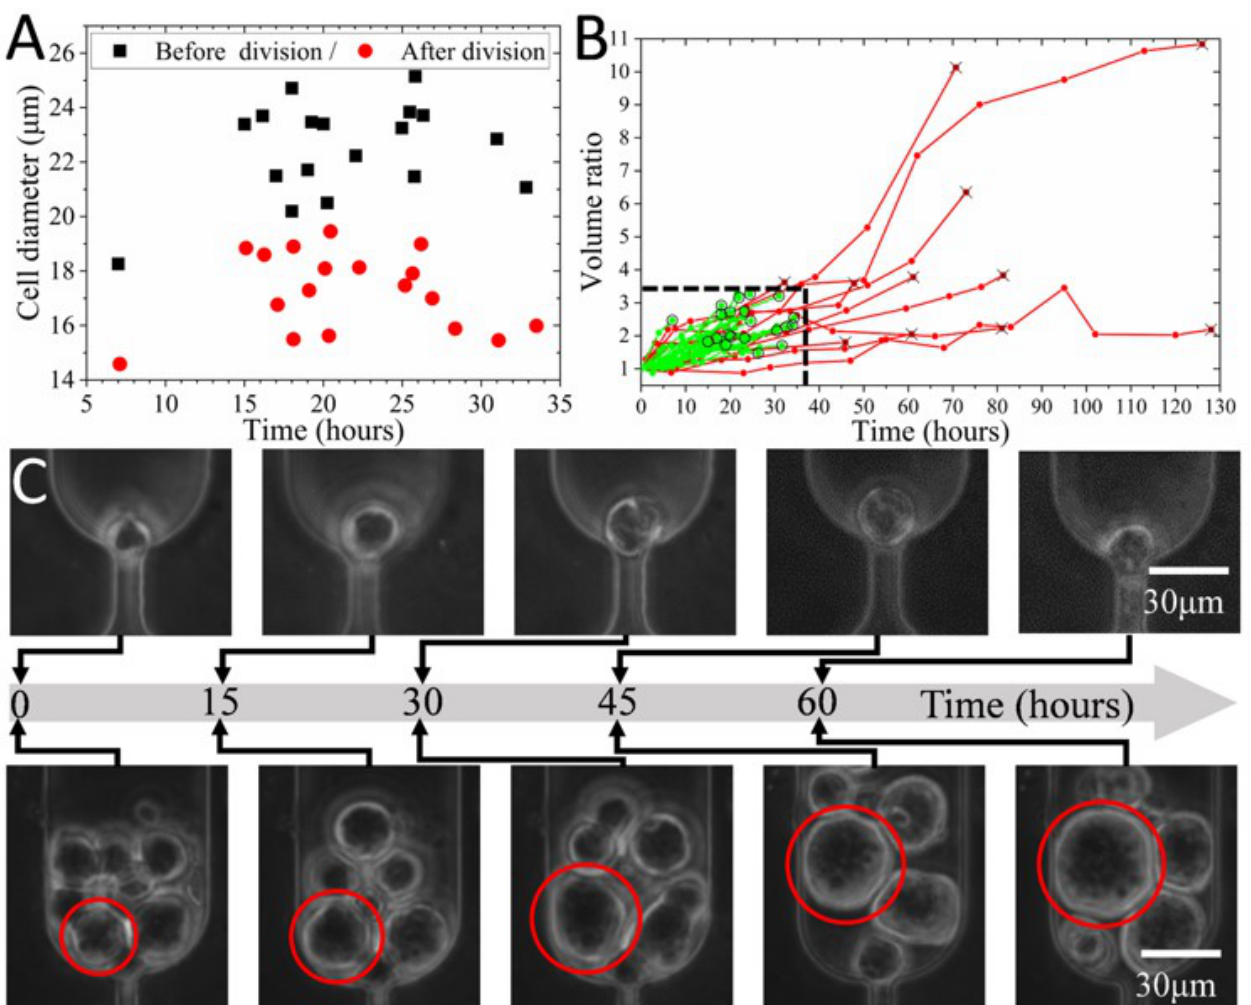
Figure 7. The size variation of different cells during culture. ( A ) The size of cells immediately before and after division (N = 18). ( B ) The variation of cell volume ratio during culture (N = 33). Green lines with circles and red lines with crosses indicate the cells with or without division, respectively. ( C ) The micro photos showing cells without division with either negligible ( top ) or 10.1 times ( bottom ) volume increase in 60